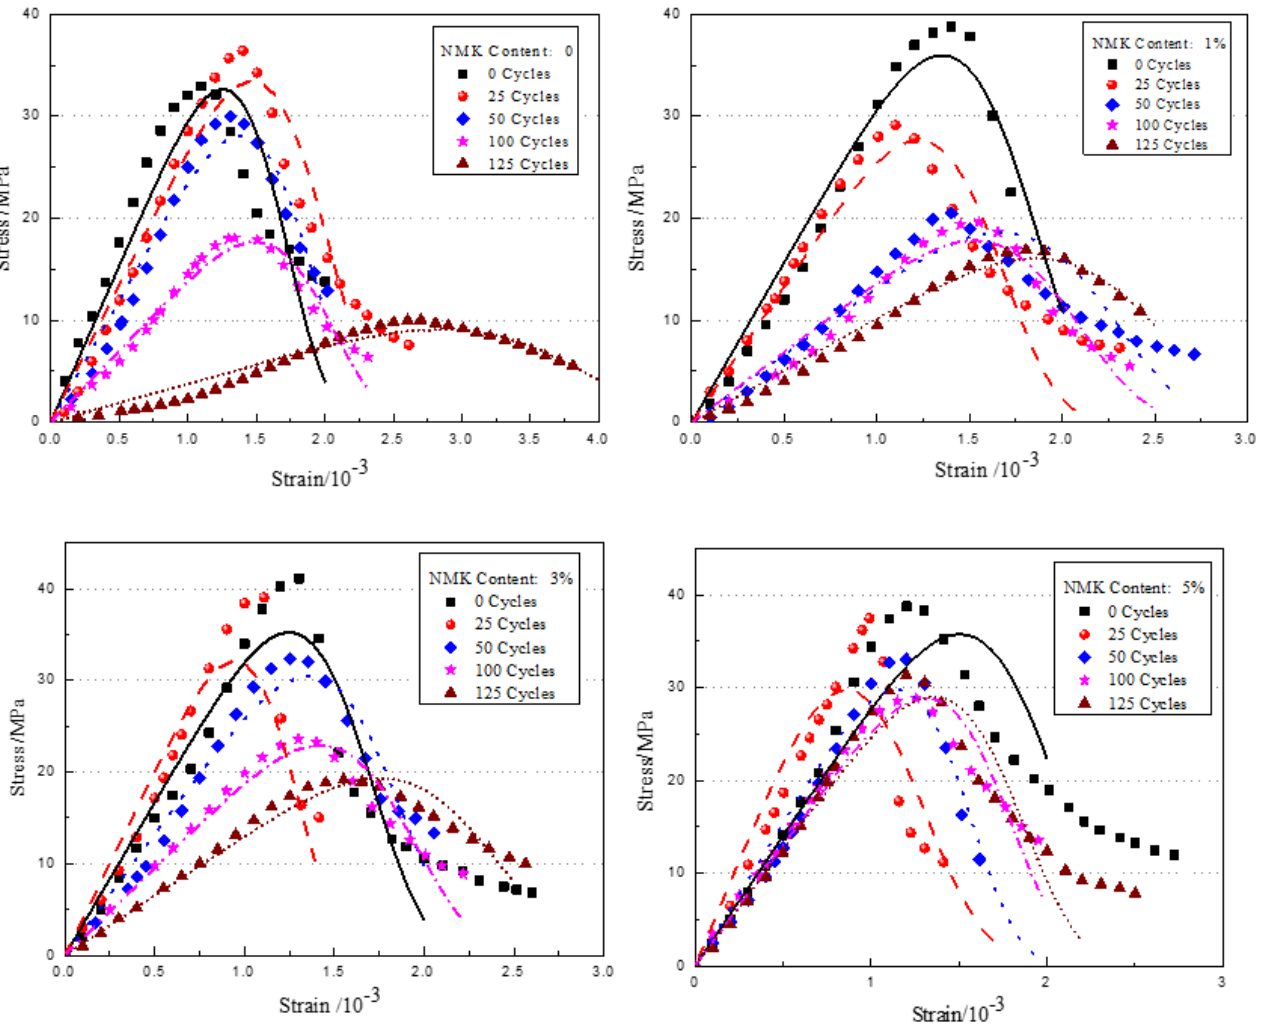
Figure 14. Experimental and theoretical curve of constitutive relationship of NMK concrete under freeze – thaw cycles.